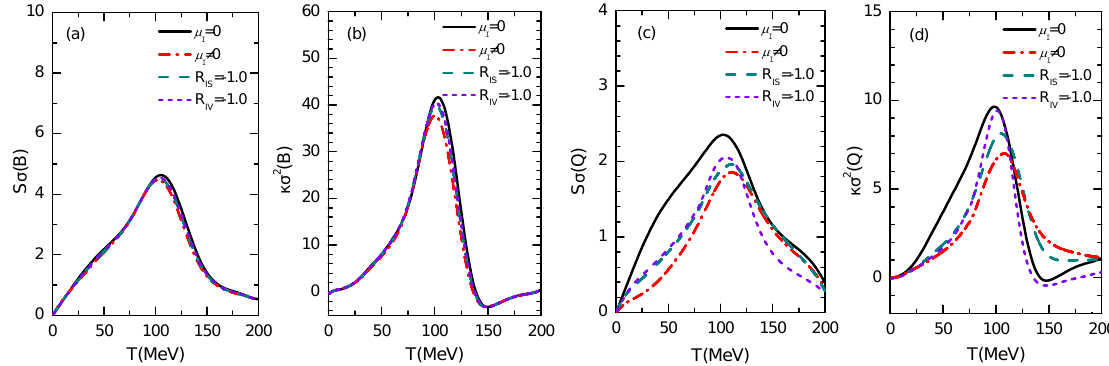
Figure 4. (color online) ( a – d ) Similar to Figure 3 but results from R IS = − 1 and R IV = − 1 are compared with